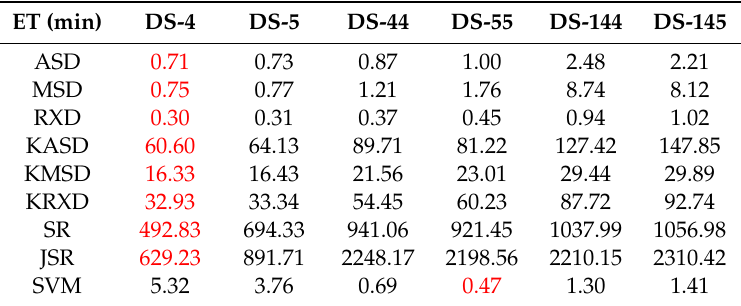
Table 9. Elapsed time (ET) values (minutes) for di ff erent methods and datasets in the training process. Red numbers indicate the most e ffi cient